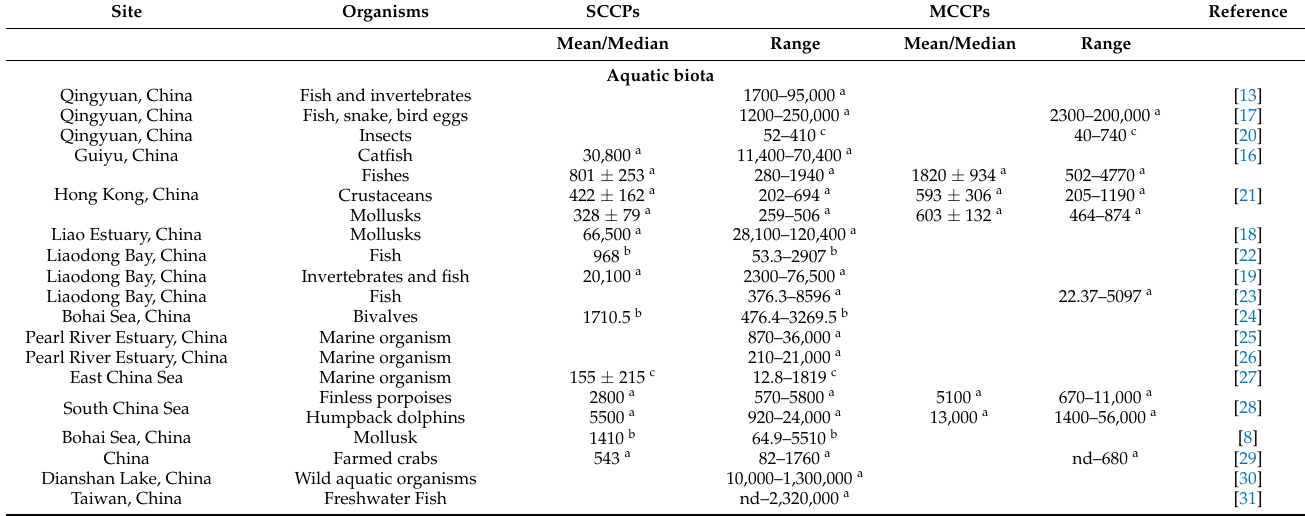
Table 1. Levels of CPs in the aquatic biota, terrestrial biota, humans, and human foodstuffs